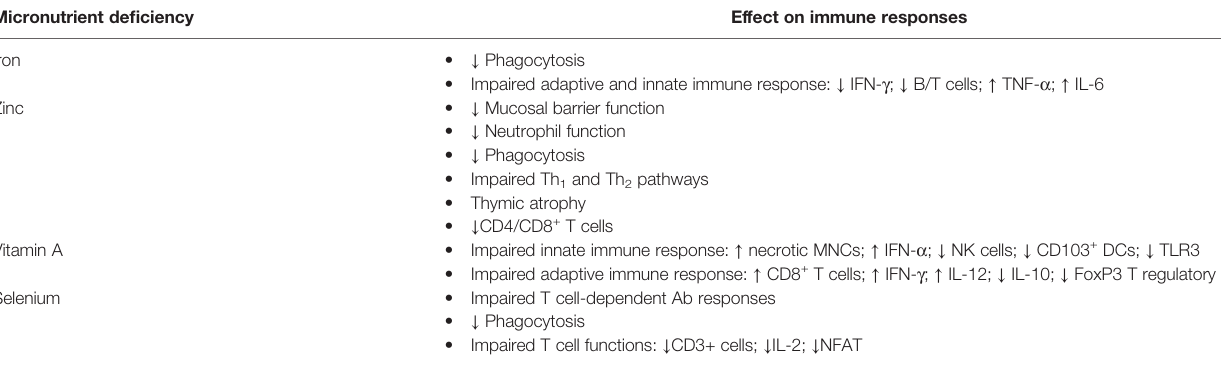
TABLE 1 | Micronutrient de fi ciencies associated with kwashiorkor and their effects on immune response in children. Micronutrient de fi ciency Effect on immune